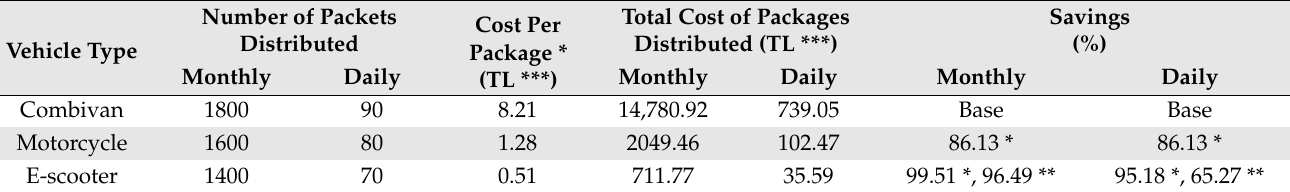
Table 5. The vehicle types in terms of the economic